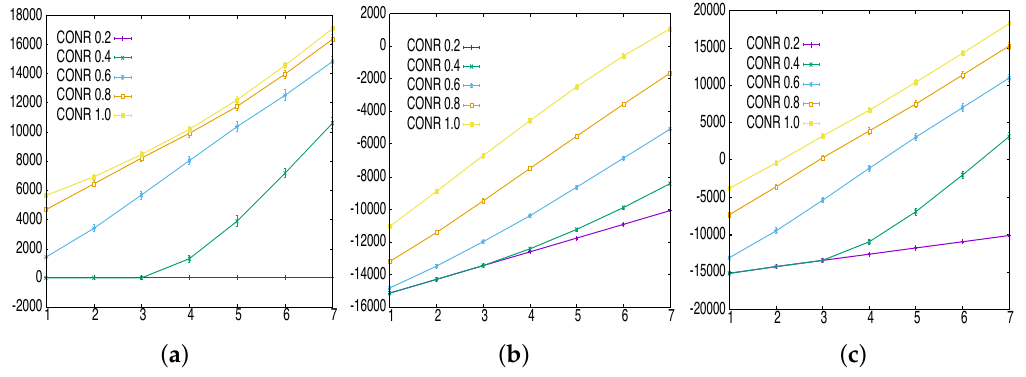
Figure 5. Agents’ utility under seven market conditions. ( a ) Buyers’ utility; ( b ) Sellers’ utility; ( c ) Total